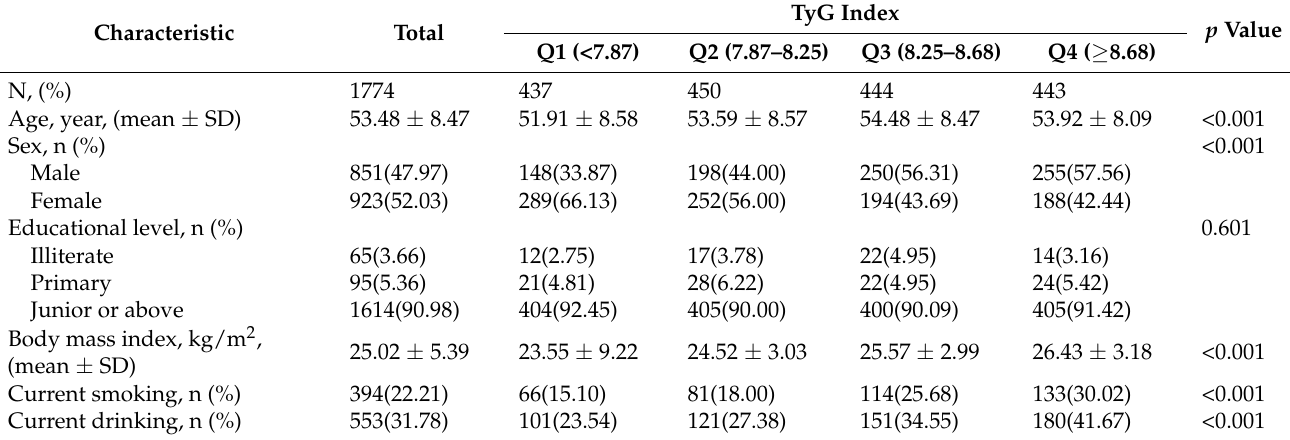
Table 1. Baseline characteristics in 2015 of these 1774 participants according to quartiles of the TyG